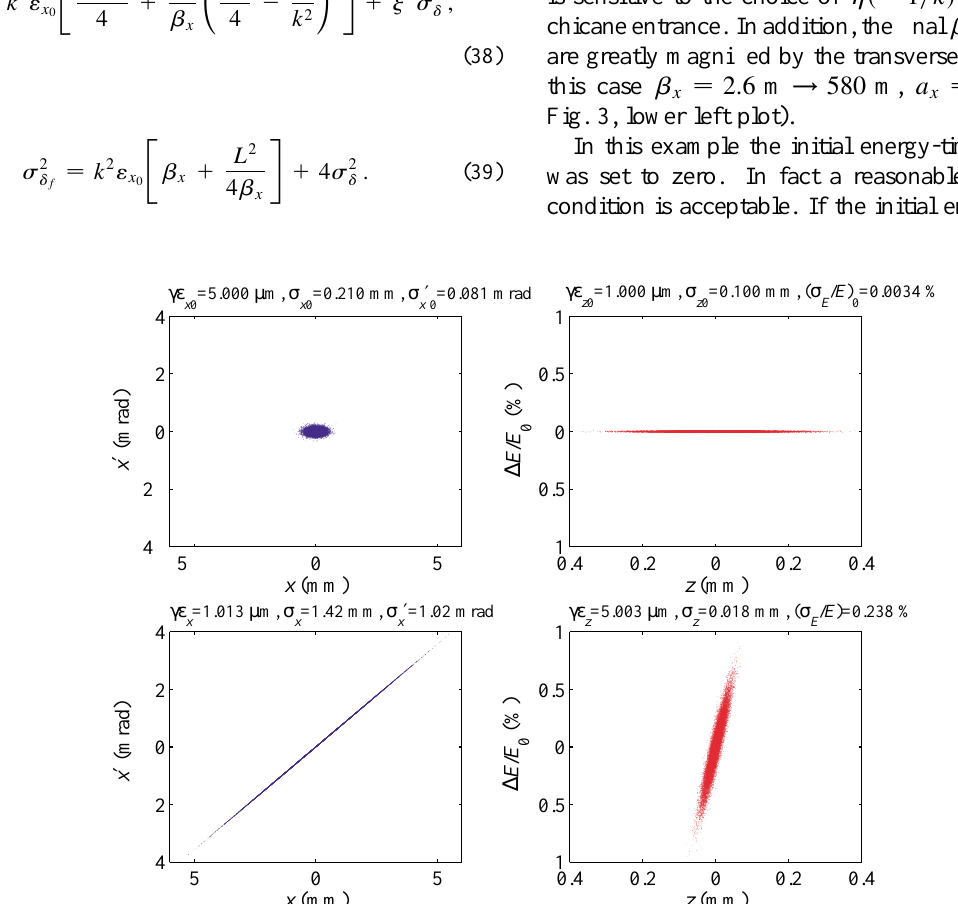
FIG. 3. (Color) Initial (top) and final (bottom) phase space tracking plots. The horizontal and longitudinal emittances are completely exchanged, as predicted by (36).